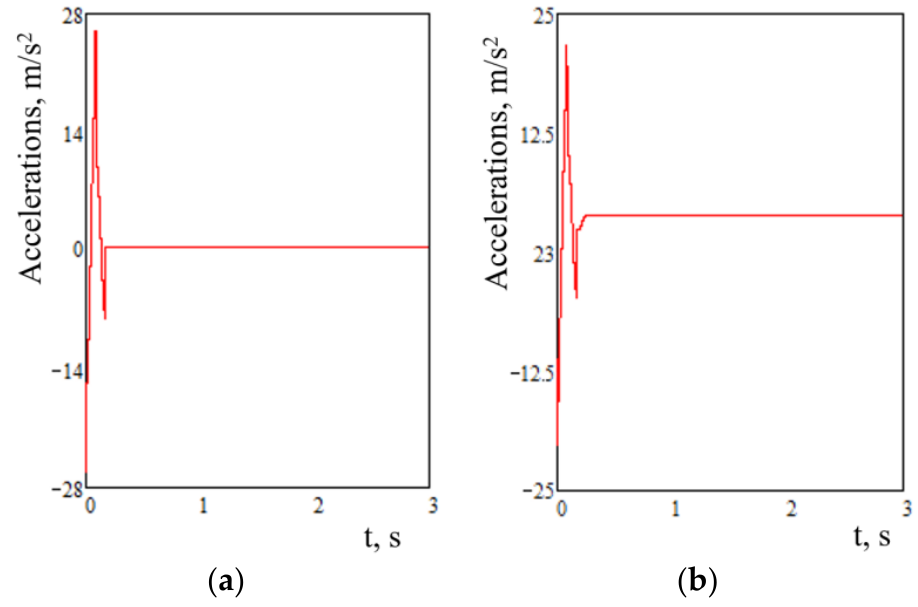
Figure 3. The accelerations to the carrying structure of the flat wagon: ( a ) First section from force application. ( b ) second section from force application.